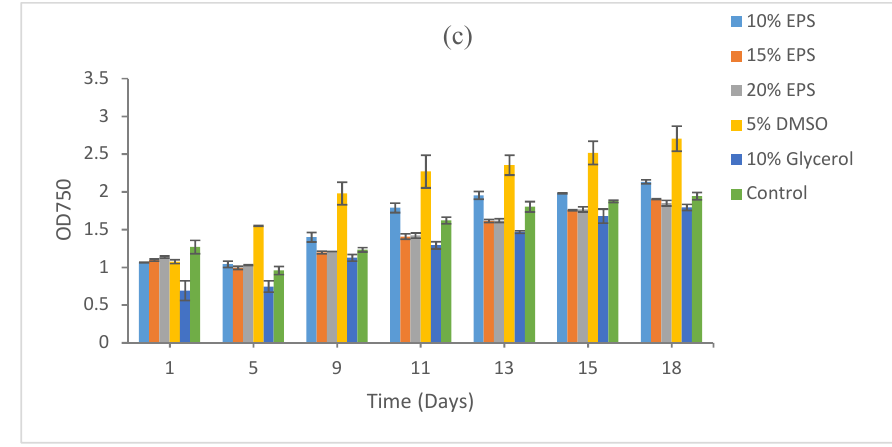
Figure 5. Growth recovery for Chlorella vulgaris after cryopreservation for ( a ) 5 days, ( b ) 15 days, and ( c ) 9 months. Duplicate samples were measured. The images of cultures at the end points refer to Figure S7.